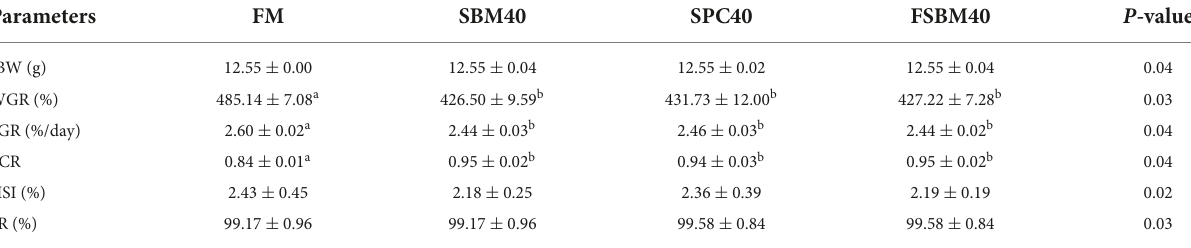
TABLE 4 Effect of different soy meals at 40% substitution level for fish meal on the growth of grouper ( n = 4).